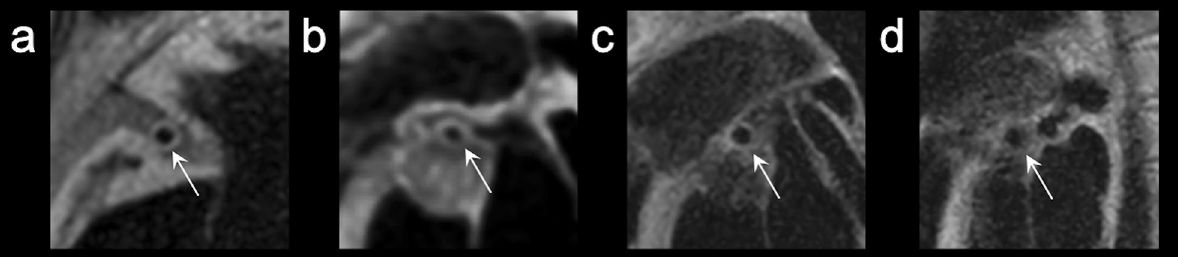
Figure 3. Image quality assessment of outer wall boundary visualization quality (arrows in ( a–d ), grades 4–1). Lumen boundary visibility was assessed on a four-point scale for each coronary artery segment. Grade 4, excellent (entire vessel wall was clearly visible); grade 3, good (vessel wall was visible, but a portion was unclear); grade 2, fair (vessel wall was unclear, but 2/3 circumference was visible); grade1, bad (more than 1/3 of the vessel wall was not visible).